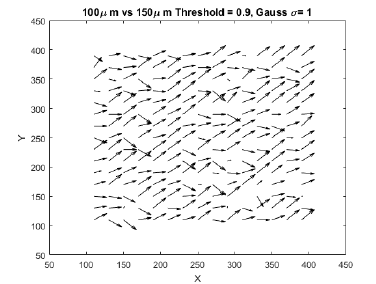
Figure 9. Results from two-dimensional digital image correlation method in